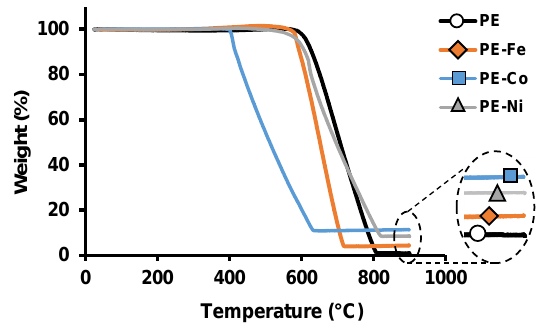
Figure 6. TGA in air. Heating rate of 10 °C min −1 .